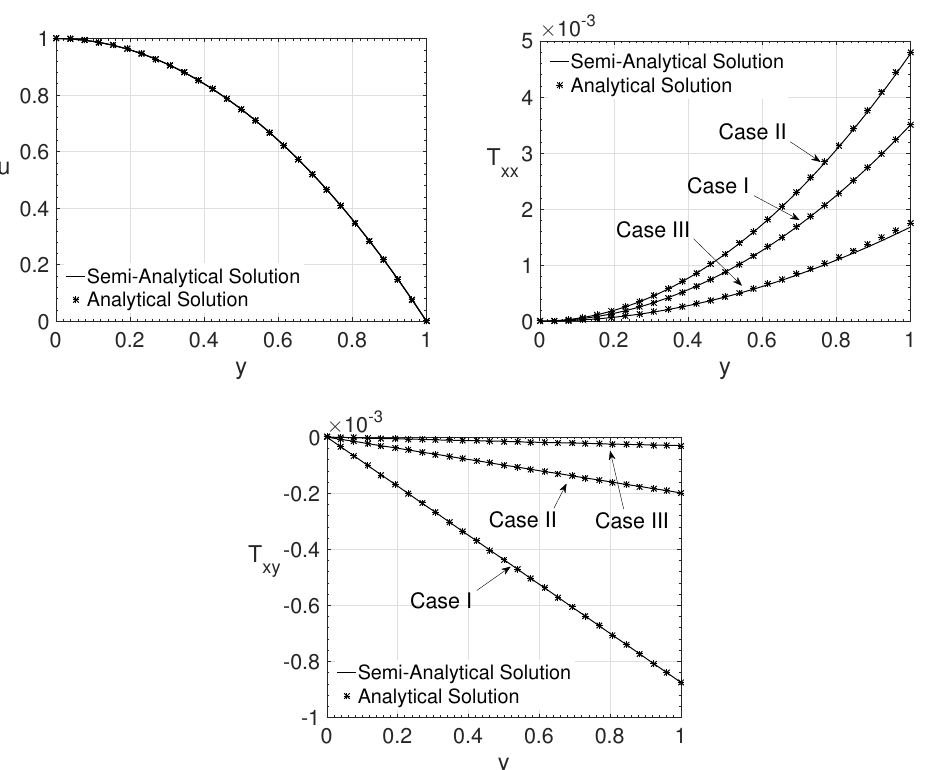
Figure 2. Wall-normal variation y of the streamwise velocity component u and the extra-stress tensor components T xx and T xy for the cases I, II and